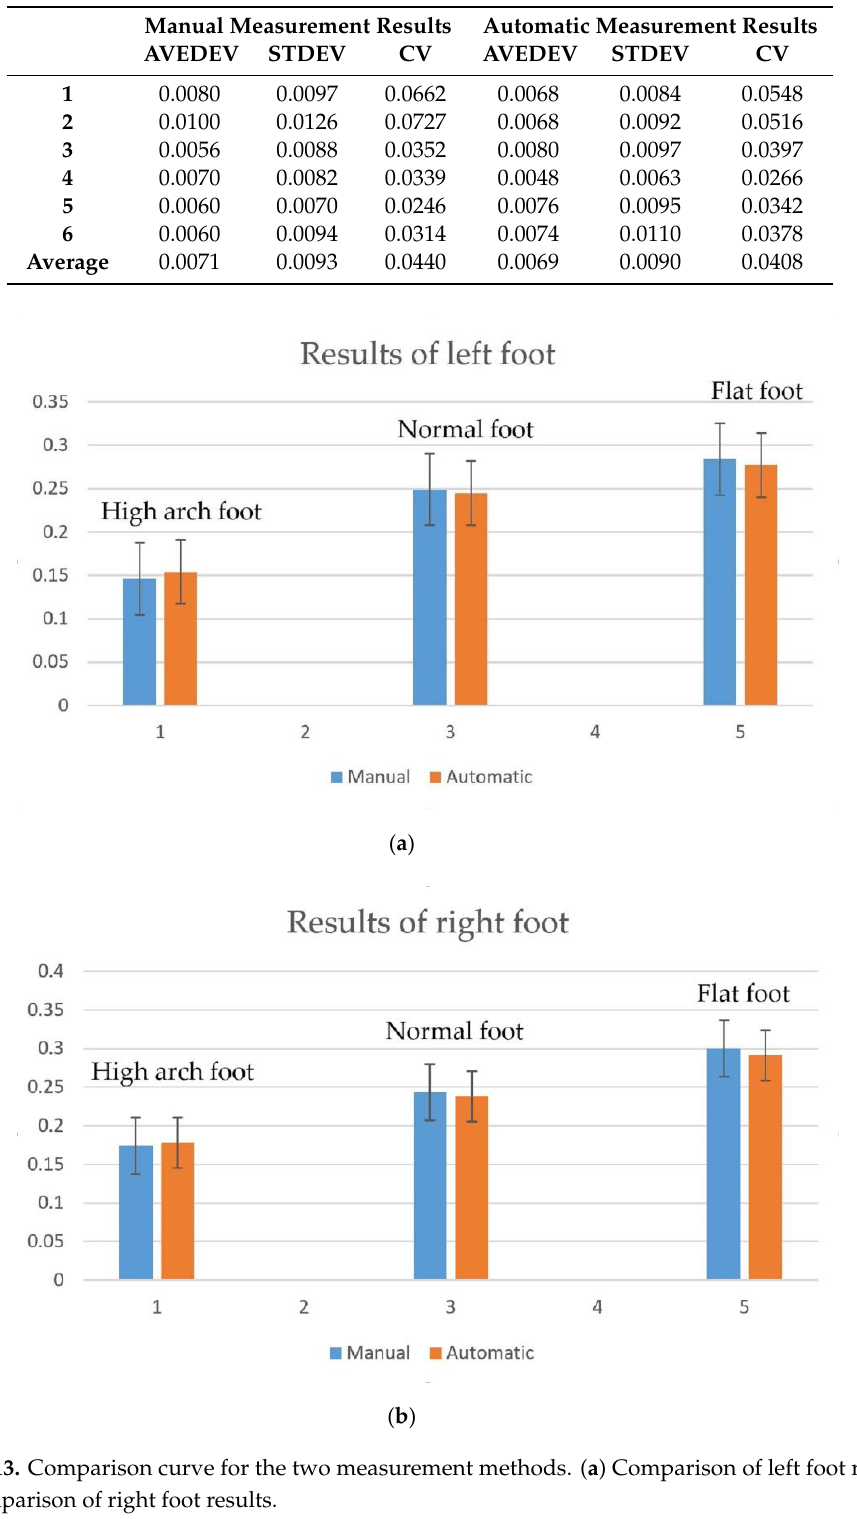
Table 4. Deviation assessment.